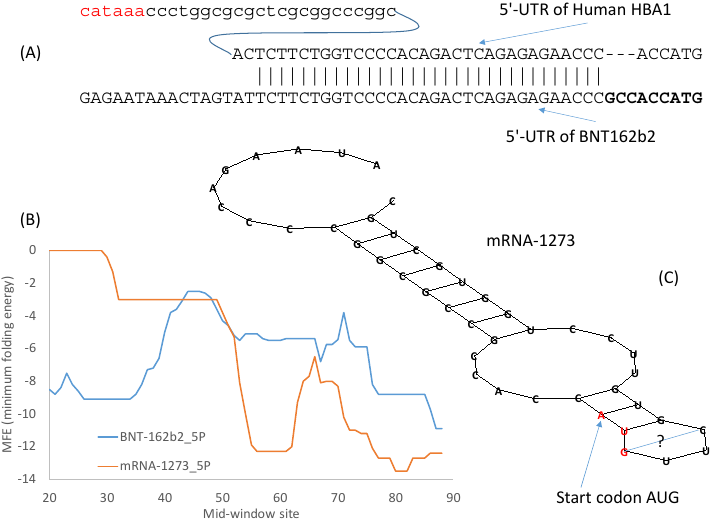
Figure 2. 5’-UTR and secondary structure of the two vaccine mRNAs. ( A ) 5’-UTR of BNT162b2 was partially taken from human α -globin gene where the 37-nt 5’-UTR is shared by HBA1 and HBA2 mRNAs. The upstream TATA box is colored in red, and the Kozak consensus highlighted in bold. ( B ) Secondary structure stability measured by MFE (minimum folding energy) over a sliding windows of 40 nt, with start codon AUG at Mid-window sites 55–57. A strong secondary structure (small MFE) is visible in sequences flanking the start codon in mRNA-1273. ( C ) Visualization of the secondary structure embedding the start codon in mRNA-1273.